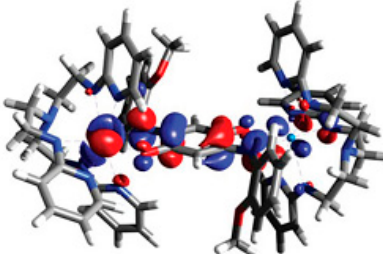
Figure 24. SOMO-2 of the [U(L)] 2 Q OMe quintet state system. Plot surfaces displayed with an iso-value of 0.02 au (reprinted with permission from [156], the Royal Society of Chemistry, 2017).